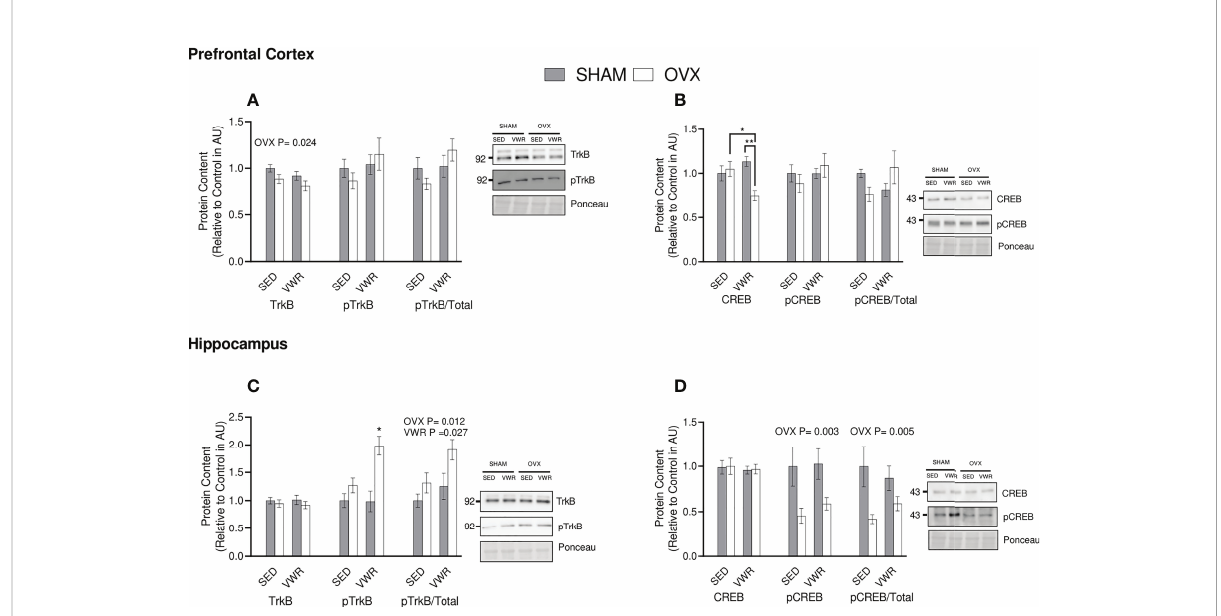
FIGURE 5 BDNF Signaling. (A) Prefrontal cortex total TrkB, pTrkB (AU) and pTrkB/total TrkB ratio. (B) Hippocampus total TrkB, pTrkB (AU) and pTrkB/total TrkB ratio. (C) Prefrontal cortex total CREB, pCREB (AU) and pCREB/total CREB ratio. (D) Hippocampus total CREB, pCREB (AU) and pCREB/total CREB ratio. All graphs are accompanied by representative blots. All data analyzed using a two-way ANOVA, TrkB, tropomyosin receptor kinase B; CREB, cAMP response element-binding protein; AU, arbitrary units; SED, sedentary; VWR, voluntary wheel running; OVX, ovariectomized; SHAM, sham operated. Signi fi cance is set to *P ≤ 0.05; **P ≤ 0.005; P ≤ 0.05; n=10 per